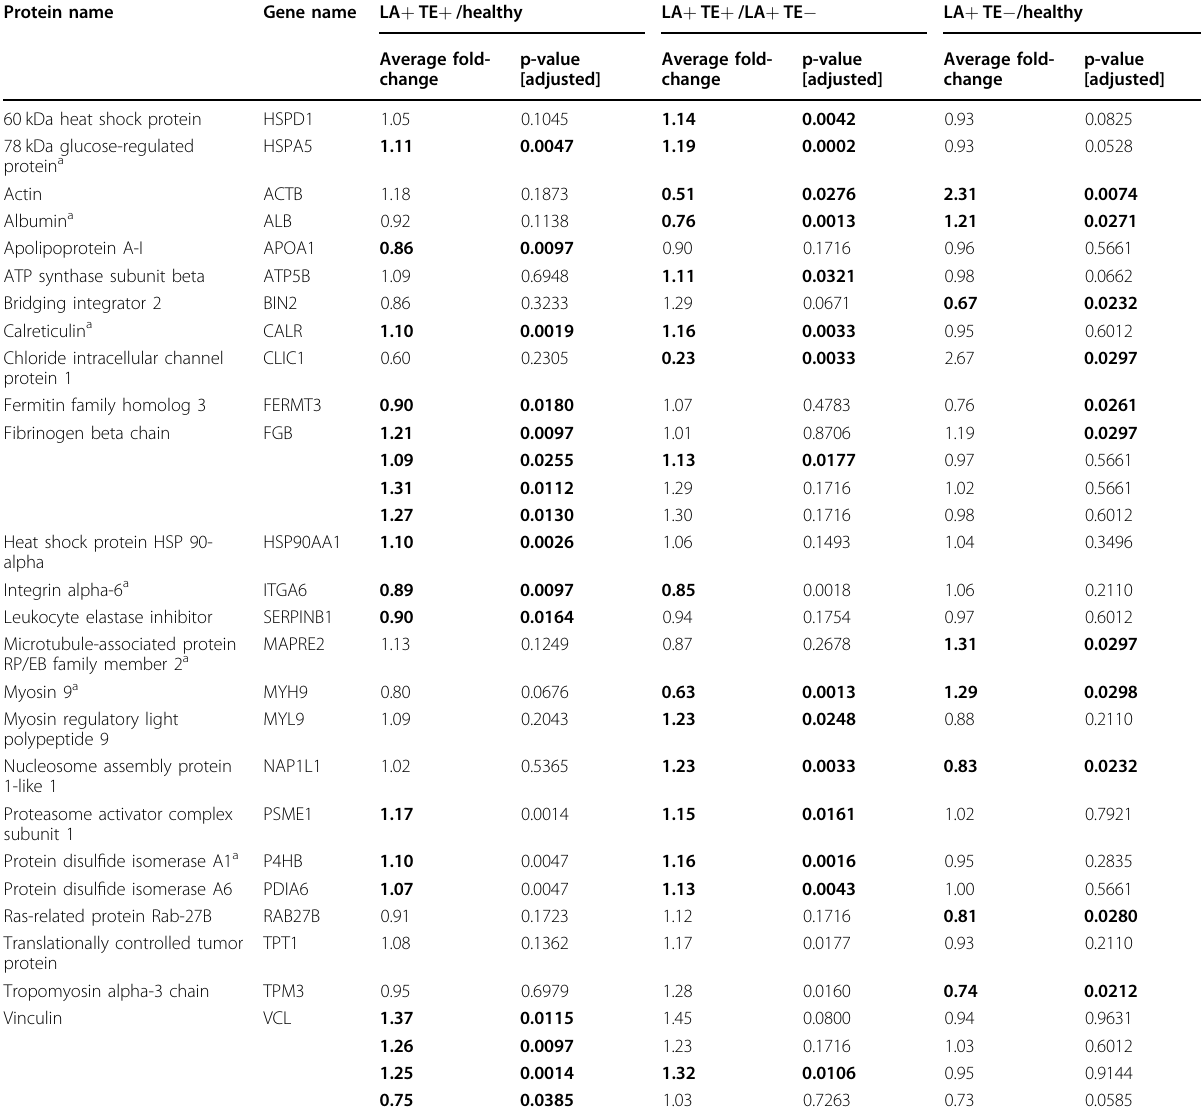
Table 2 Altered platelet proteins between LA + TE + patients, LA + TE − patients and healthy controls analyzed by 2D-